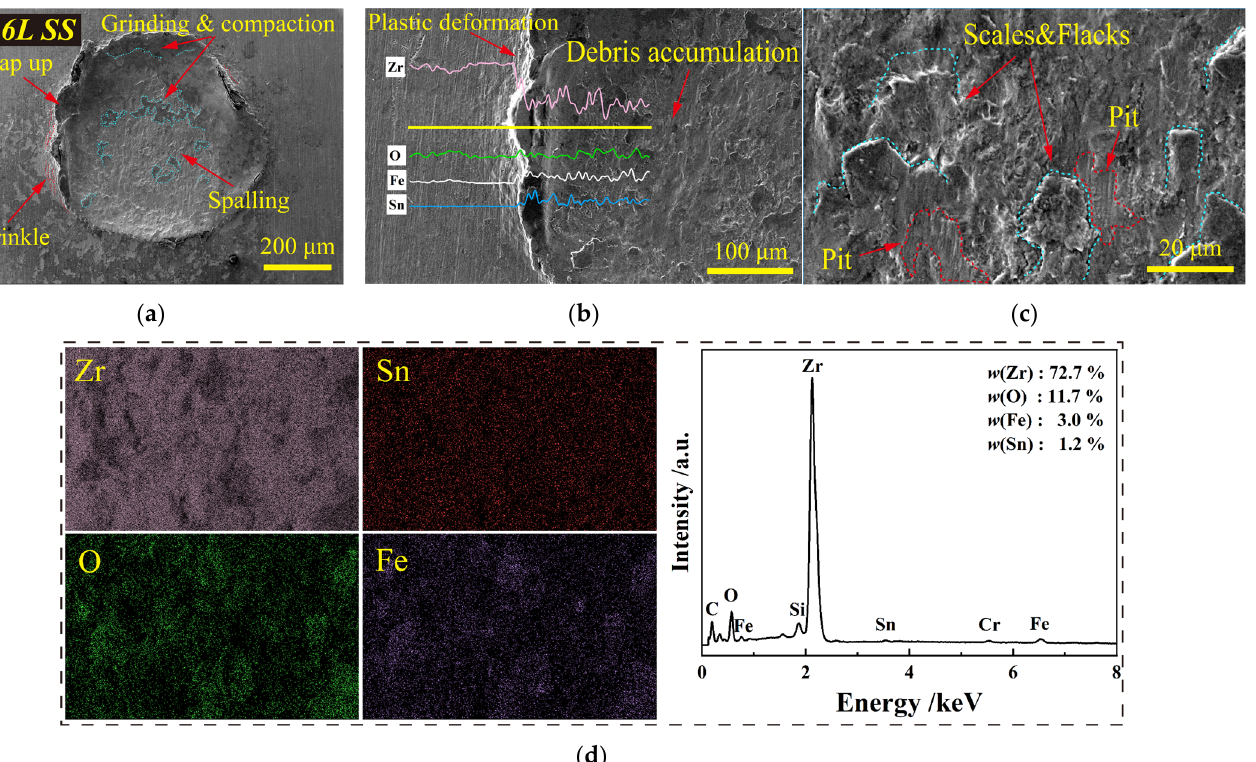
Figure 12. SEM micrographs of wear scar and EDS after being cyclically impacted by 316L SS impact block 500,000 times. ( a ) Wear scar morphology; ( b ) line scan spectrum; ( c ) wear debris accumulation; ( d ) wear debris spectrum.